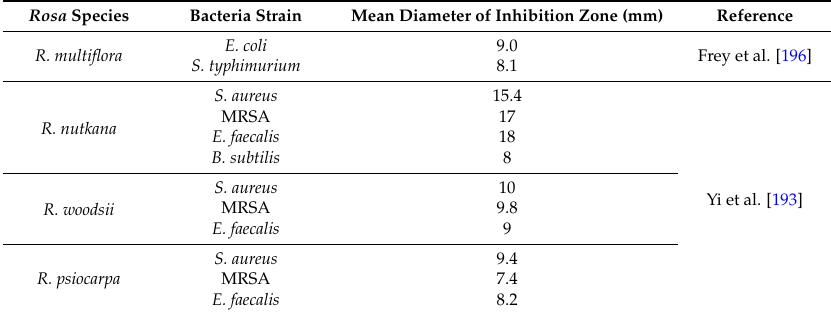
Table 3. Antibacterial effect of some Rosa species displayed as mean diameter of inhibition zone.